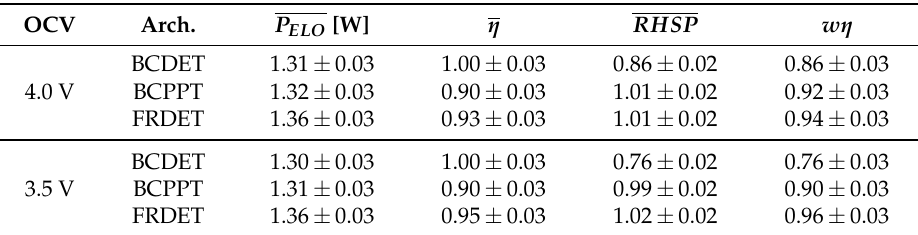
Table 9. Summary of the